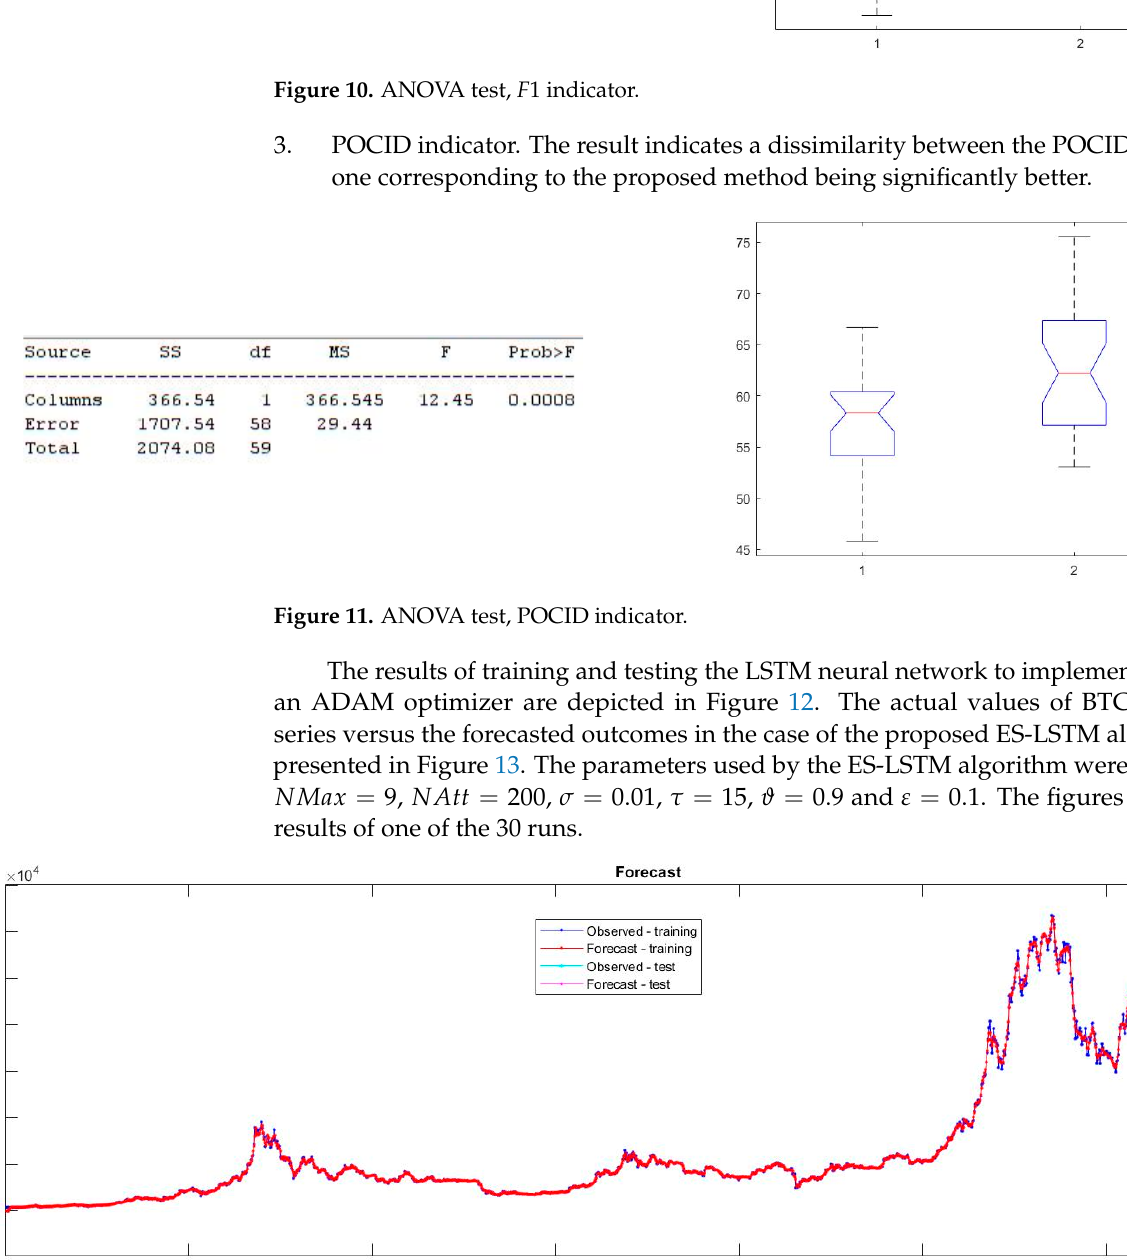
Figure 13. BTC–USD: ES-LSTM training. b. The correlogram analysis of the ETH–USD data is provided in Figure 14. The target variable together with its filtered version are presented in Figure 15.